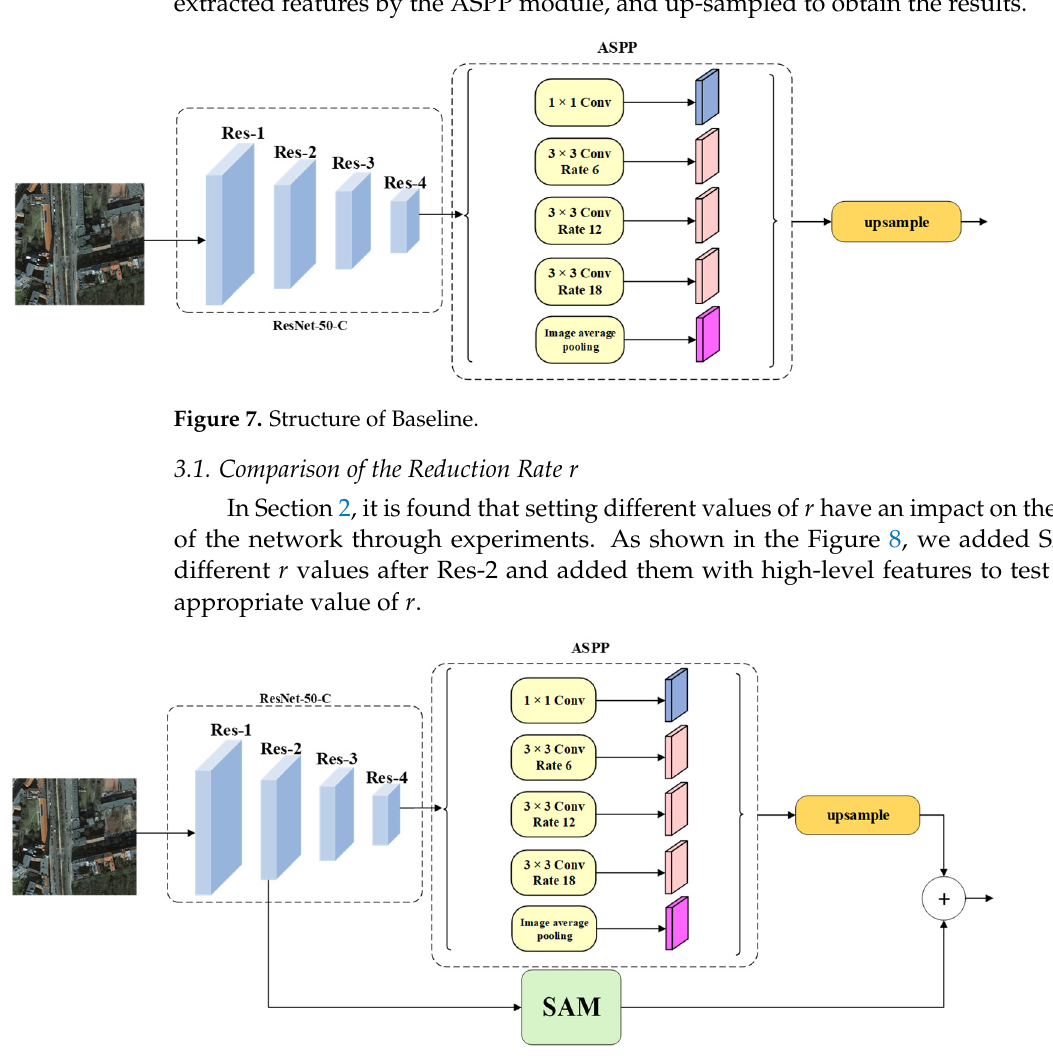
Table 1. Comparison of dimensionality reduction rates of strip attention modules based on the CITY-OSM dataset. (Data in bold are the best